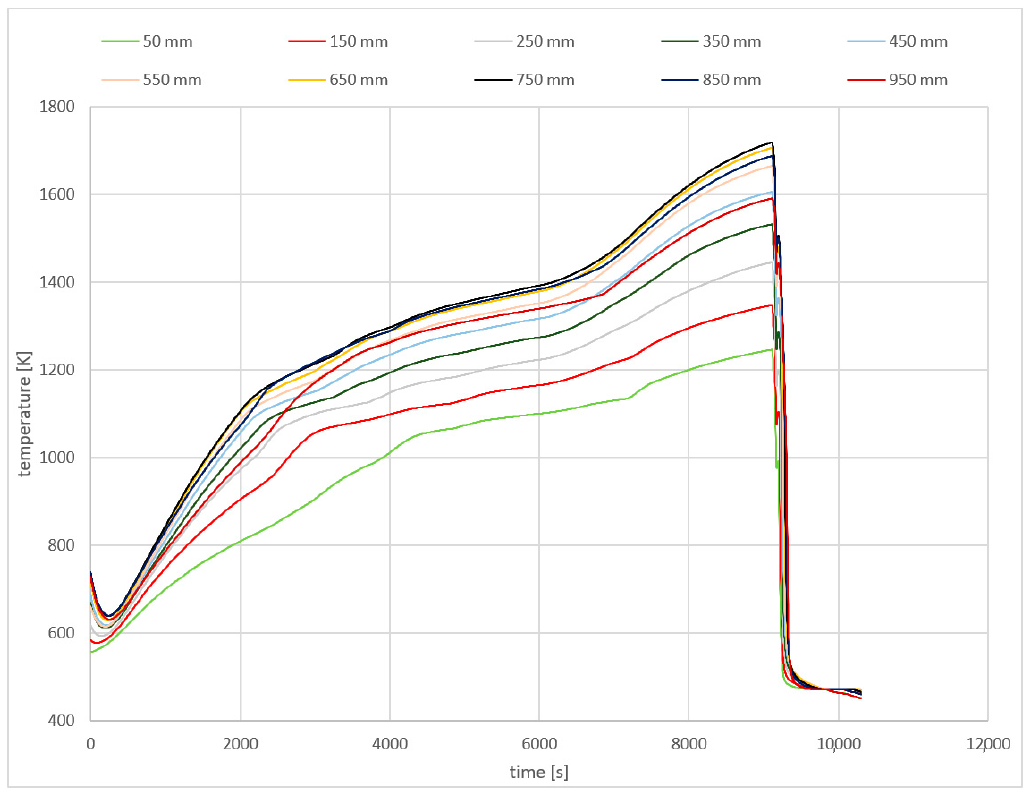
Figure 8. Temperatures calculated by MELCOR in the heated part of the bundle and the peripheral ring (axial level, number of rings).